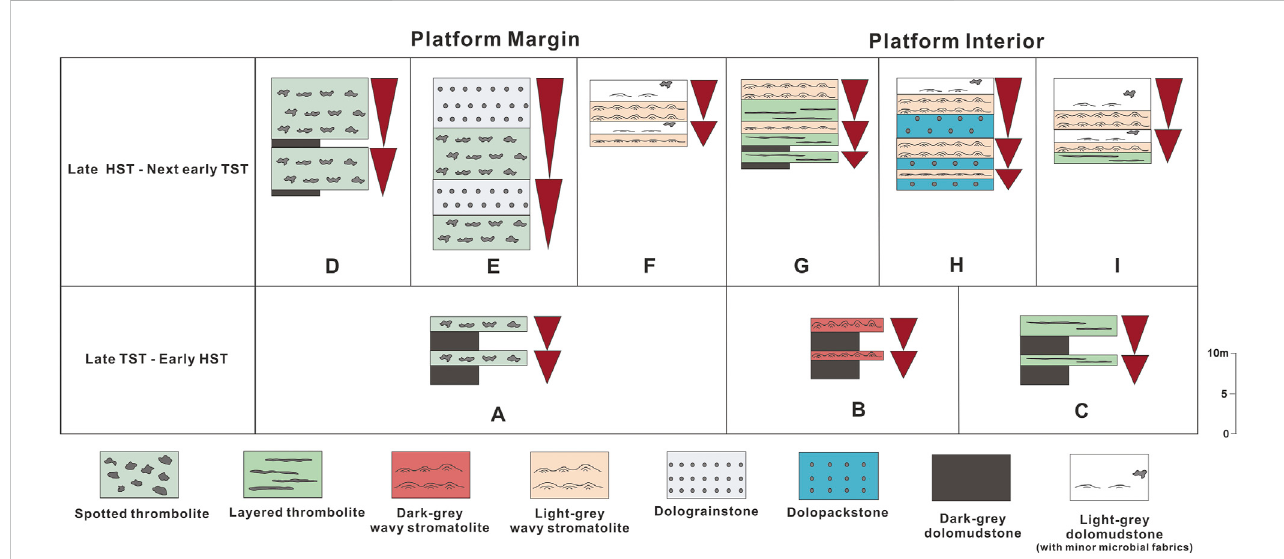
FIGURE 6 Microbialite lithofacies associations of the Z 2 dn 4 of the Gaoshiti-Moxi area in a fourth-order sequence stratigraphic framework. (A) thick-bedded dark- grey dolomudstone-thin-bedded spotted thrombolite; (B) thick-bedded dark-grey dolomudstone-thin-bedded dark-grey wavy stromatolite; (C) thick- beddeddark-greydolomudstone-thin-beddedlayeredthrombolite; (D) thin-beddeddark-greydolomudstone-thick-beddedspotted thrombolite; (E) thick- bedded spotted thrombolite-dolograinstone; (F) thin-medium-bedded light-grey wavy stromatolite-light-grey dolomudstone; (G) thin-medium- bedded dark-grey dolomudstone-layered thrombolite-wavy stromatolite; (H) thin-medium-bedded dolopackstone-light-grey wavy stromatolite-light-grey dolomudstone; (I) thin-bedded layered thrombolite-wavy stromatolite-light-grey